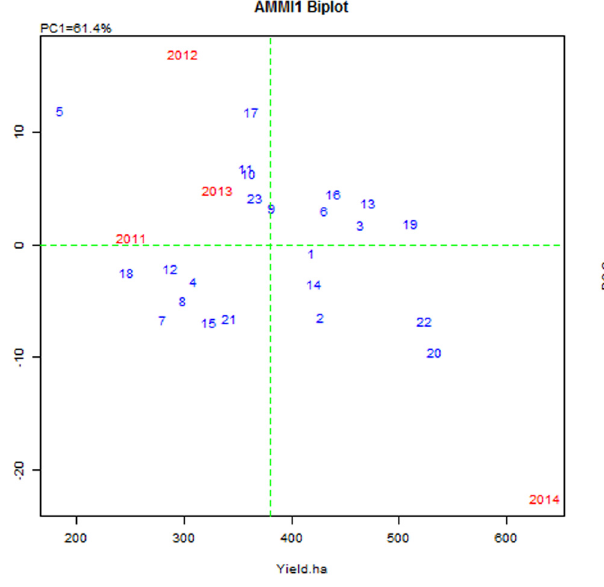
Figure 2: GGE biplot showing the ranking of AYB genotypes for both mean yield and stability across the four - year